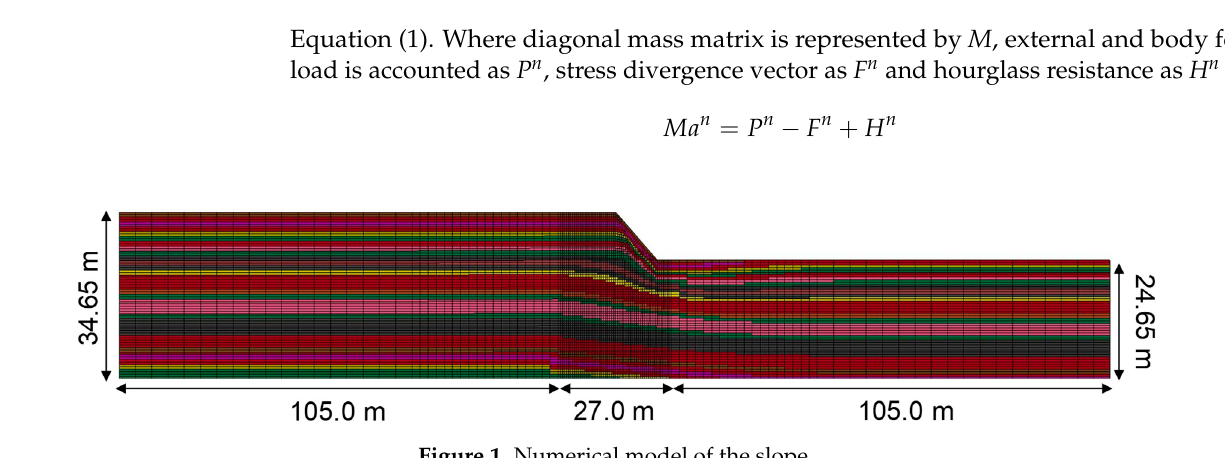
Figure 1. Numerical model of the slope.